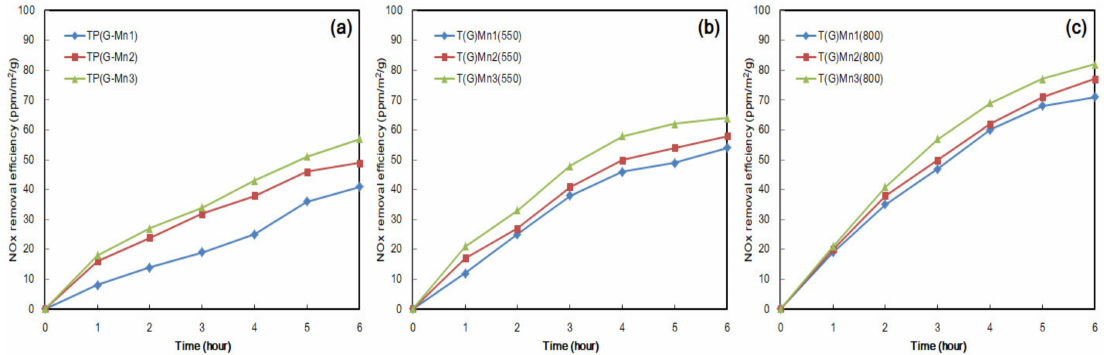
Figure 5. Photocatalytic NOx removal e ffi ciency for ( a ) TP(G–Mn1), TP(G–Mn2) and